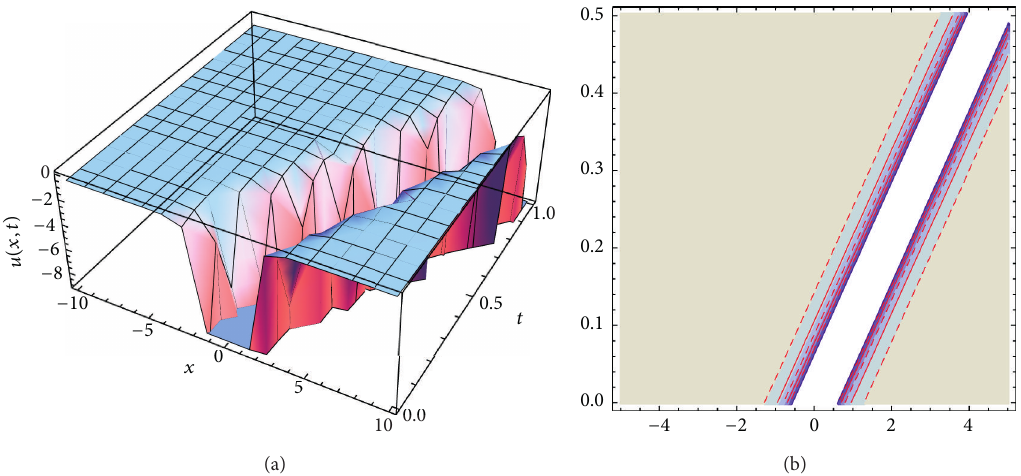
Figure5:(a)Travellingwavessolutionsof (37)isplotted:stabilitydarksolitarywaves.(b)Travellingwavessolutionsof (37)isplotted:stability contour of solitary waves.